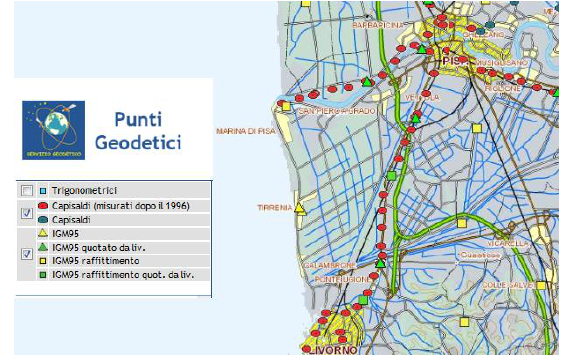
Figure 8. Distribution of leveling lines along the Pisa coast